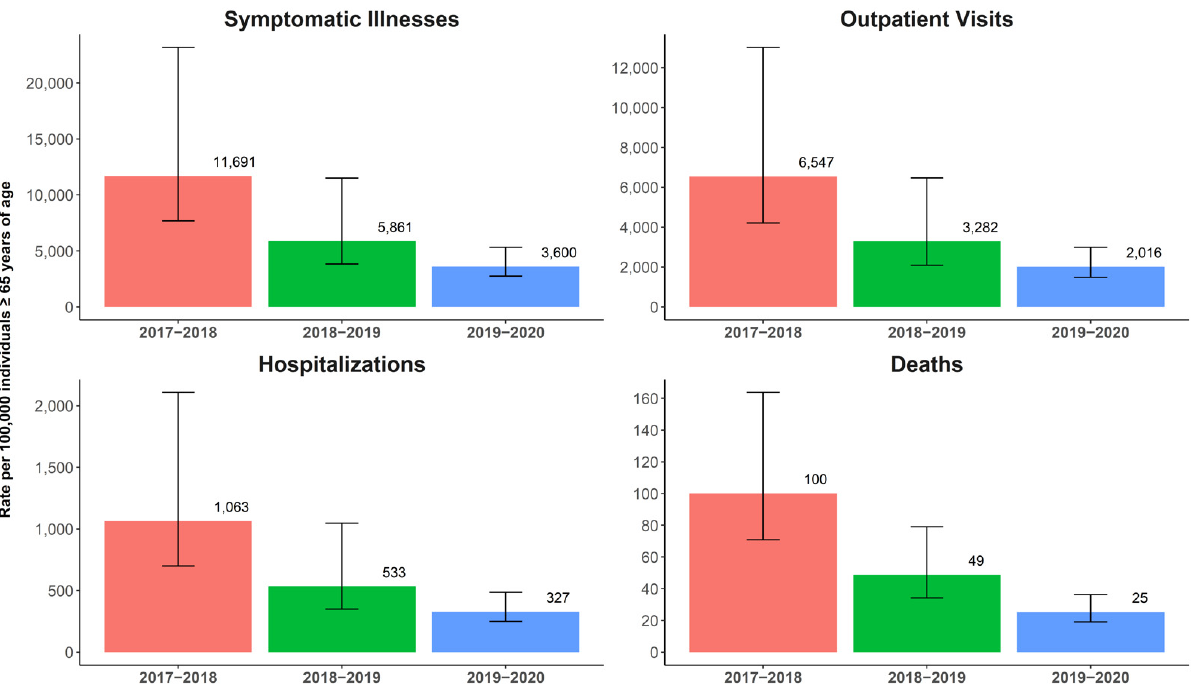
Figure 1. Estimated incidence rates (and 95% uncertainty interval) of influenza-related outcomes (symptomatic illnesses, outpatient visits, hospitalizations, and deaths) per 100,000 individuals ≥ 65 years of age as estimated by the US Centers for Disease Control and Prevention (CDC) for seasons